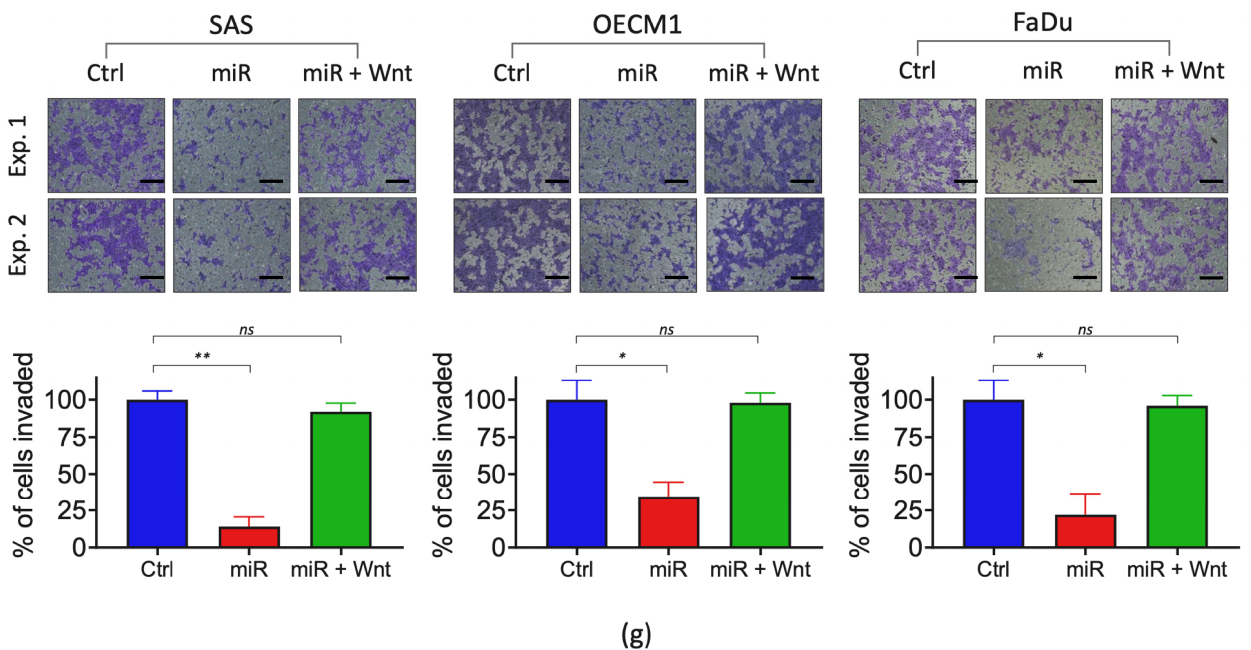
Figure 3. Prediction and validation of WNT3A as a target of miRNA-503. ( a ) Bioinformatics approach for the prediction of miR-503 genes. The TargetScan, miRanda, DIANA, miRSystem, and starBase prediction algorithm databases were incorporated. ( b ) The biological processes of the predicted genes from the five databases were analyzed with KEGG. The most prominent functions included cell growth, cell motility, and WNT signaling. ( c ) The RT-qPCR analysis of the 11 commonly predicted genes of miR-503. The experiments were performed with the SAS, OECM1, and FaDu cell lines and the average expression is shown ( c , bottom). ( d ) The Western blot analysis showed that the WNT3A protein levels were significantly inhibited when miR-503 was overexpressed in SAS, OECM1, and FaDu cells. All the experiments were performed at least three times independently, and a typical result was shown. The error bars shown in the relevant figures indicate the standard deviation of the quantification results. GAPDH was used as an internal control to normalize the relative density levels of WNT3A. ( e ) A schematic representation of the luciferase reporter construction. The wild-type and mutant forms of the WNT3A 3 ′ UTR were co-transfected with a miR-503 plasmid for the dual-luciferase reporter assay. ( f ) The results were normalized to the mutant form luciferase activity levels. WNT3A co-transfection with miR-503 significantly inhibited the luciferase activity. ( g ) A rescue experiment restored the invasive ability of HNC cells when miR-503 was co-transfected with a Wnt agonist, scale bar 100 µ m. The experiments were performed in triplicates. (** p ≤ 0.01, * p ≤ 0.05, t -test, ns = not